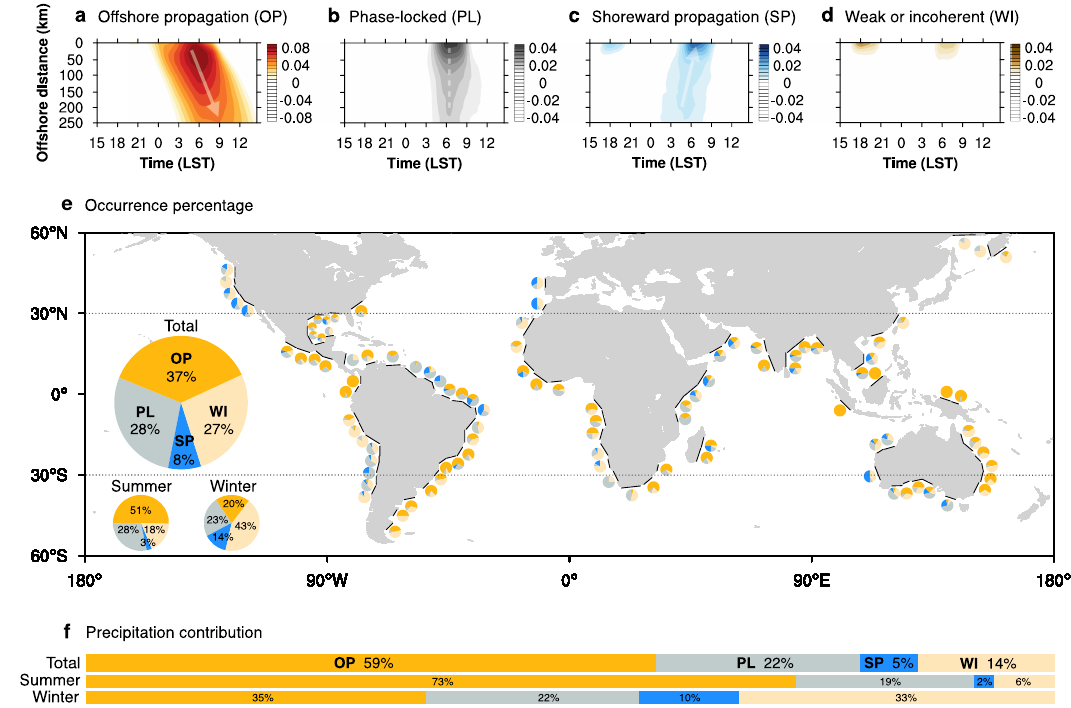
Fig.1|Classi fi cationsanddistributionsofthecoastaldiurnalrainfallpatterns. a – d Composite distance – time Hovmöller diagrams of the hourly precipitation deviation (shaded, mm) for each type. e The global occurrence distribution and total percentage of each diurnal rainfall pattern off selected coastlines. The small pie charts indicate the occurrence percentage of each type for corresponding coast,and the big pie charts indicatethetotaloccurrencepercentage of eachtype